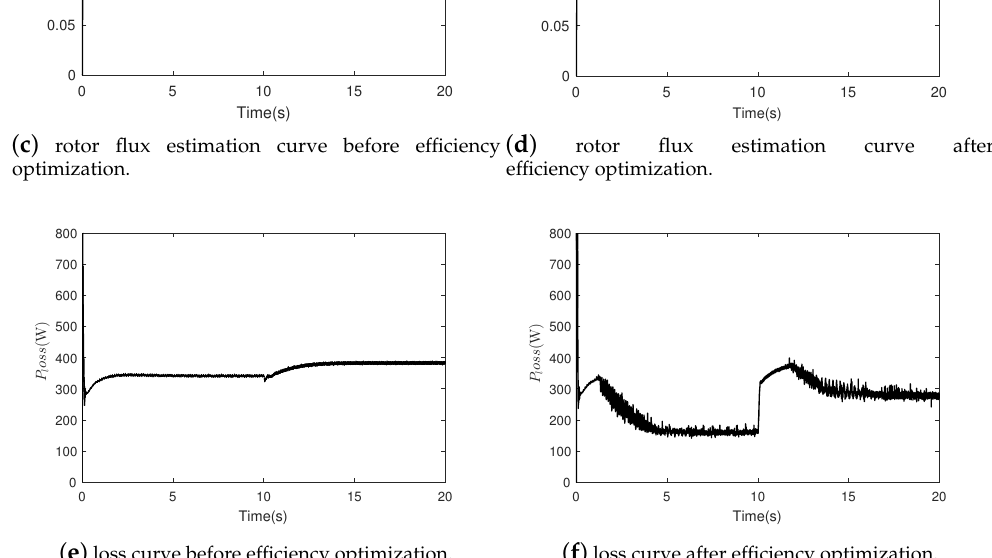
( f ) loss curve after efficiency optimization. Figure 14. The response curve before and after efficiency optimization at 600